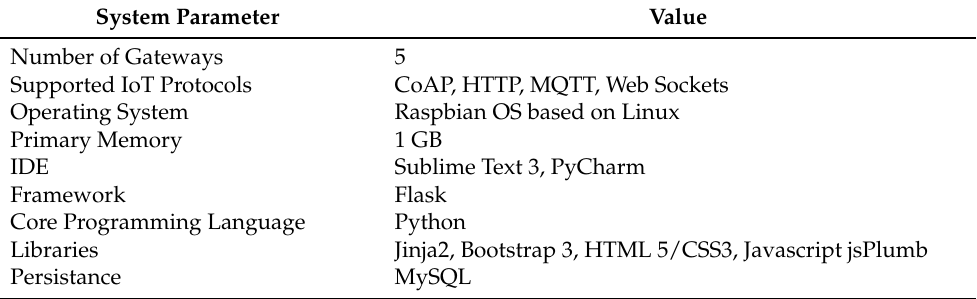
Table 5. Specification of implementation environment of application Store.